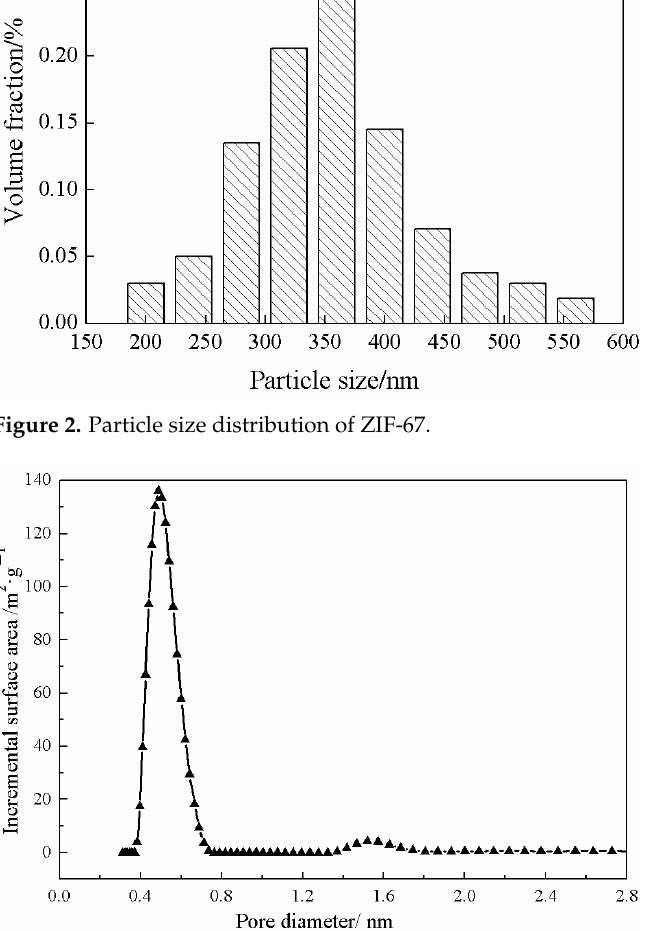
Figure 3. Pore size of as-prepared ZIF-67 particles.